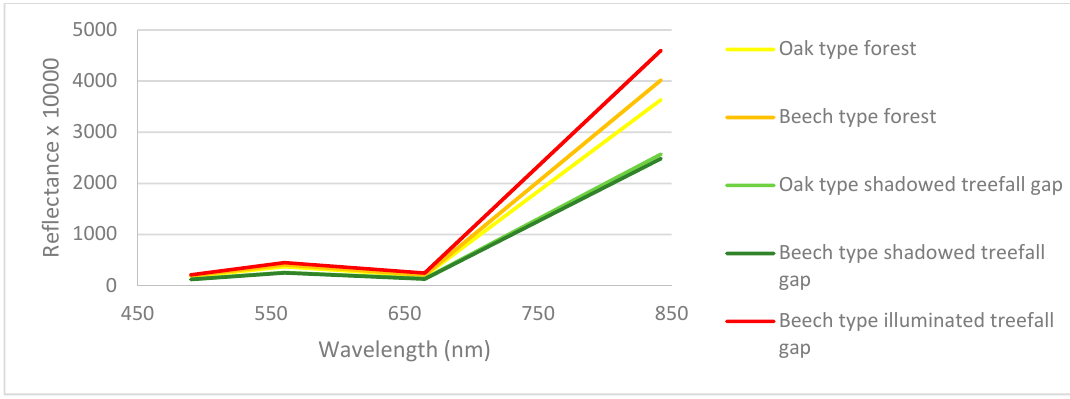
Table 2. Types and number of sampling positions for endmembers.